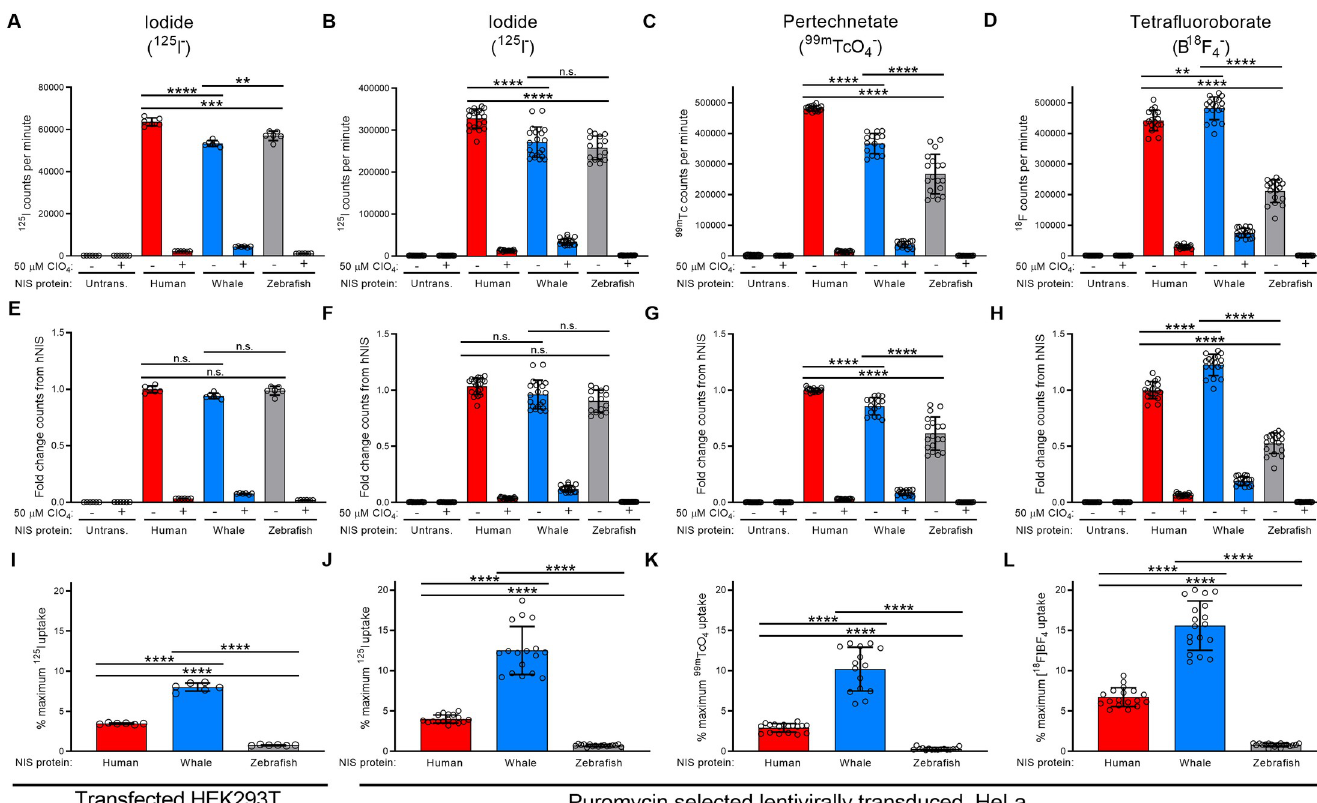
Fig 4. Characterization of radioisotope substrate uptake in HeLa cells lentivirally transduced with HA-human NIS, HA-minke whale NIS, or HA-zebrafish NIS. Raw uptake value of (A-B) 125 I - , (C) 99m TcO 4- , or (D) B 18 F 4- in the absence or presence of 50 μ M perchlorate (ClO 4 ) in transfected or transduced cells. (E-H) Uptake of each radioisotope normalized to hNIS uptake via cell surface protein expression. (I-L) The percentage of maximum 125 I - uptake activity (uptake at 0 μ M ClO 4 ) maintained in the presence of 50 μ M perchlorate (ClO 4 ). Values are averages of triplicate assays with standard deviation. n.s. indicates not significant; � indicates p < 0.05; �� indicates p < 0.01; ��� indicates p < 0.001; ���� indicates p < 0.0001; Untrans. = untransfected or